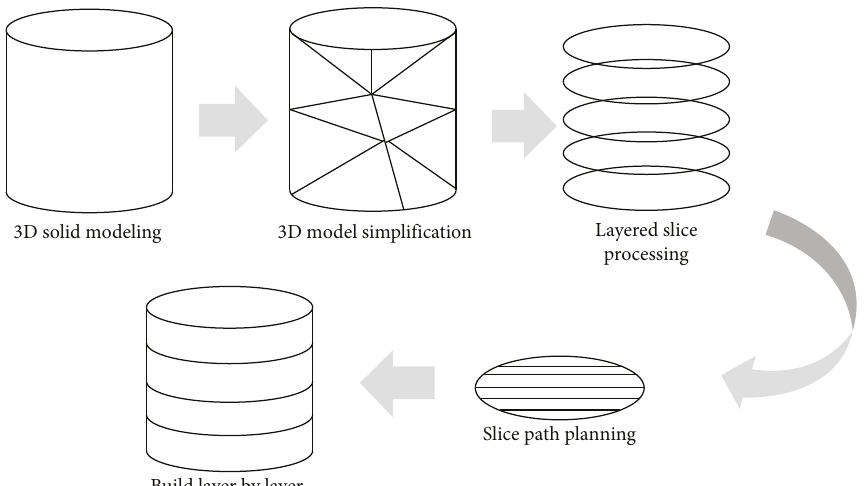
Figure 1: Forming process of additive manufacturing technology [1].